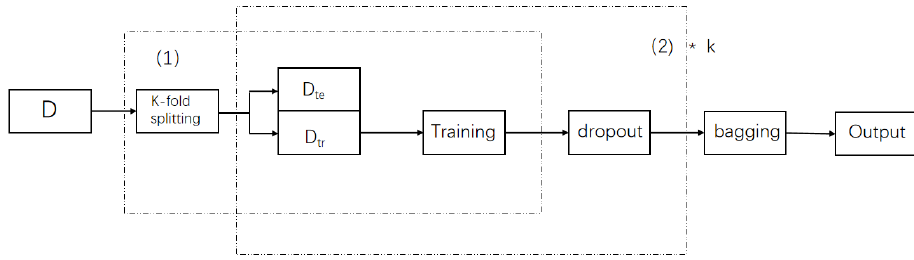
Figure 6. The architecture of optimized random forest.